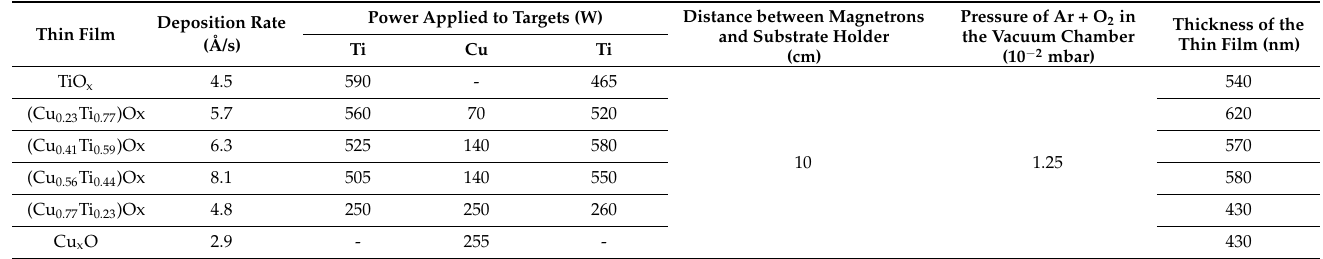
Table 1. Summary of the main process parameters for magnetron co-sputtering deposition of copper oxide (Cu x O), titanium oxide (TiO x ), and mixed copper and titanium oxides